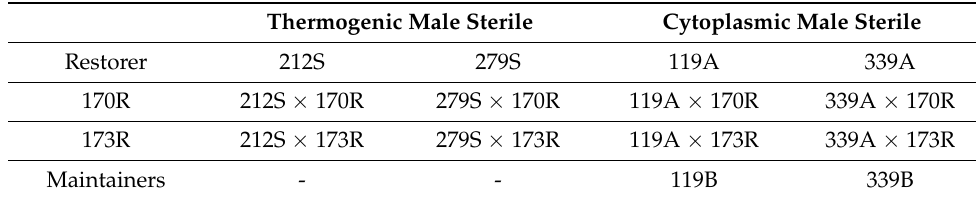
Table 1. Rice genotypes used in the